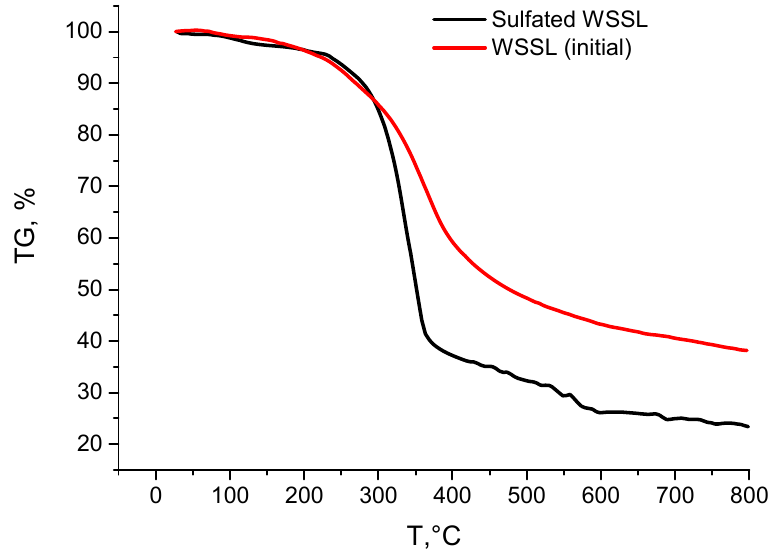
Figure 4. Results of the thermogravimetry study.